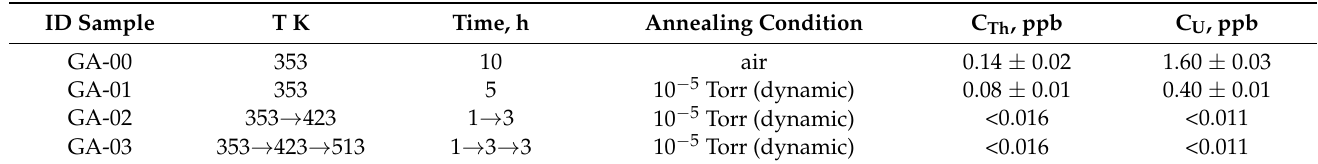
Table 7. Experimental conditions for the stepwise annealing of Gd(acac) 3 preparations.